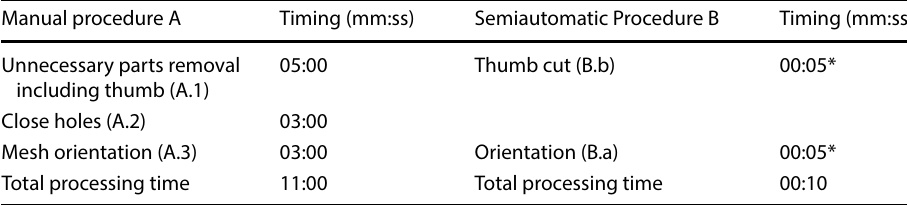
Table 1 Pre-processing phases timing comparison (ref. Fig.